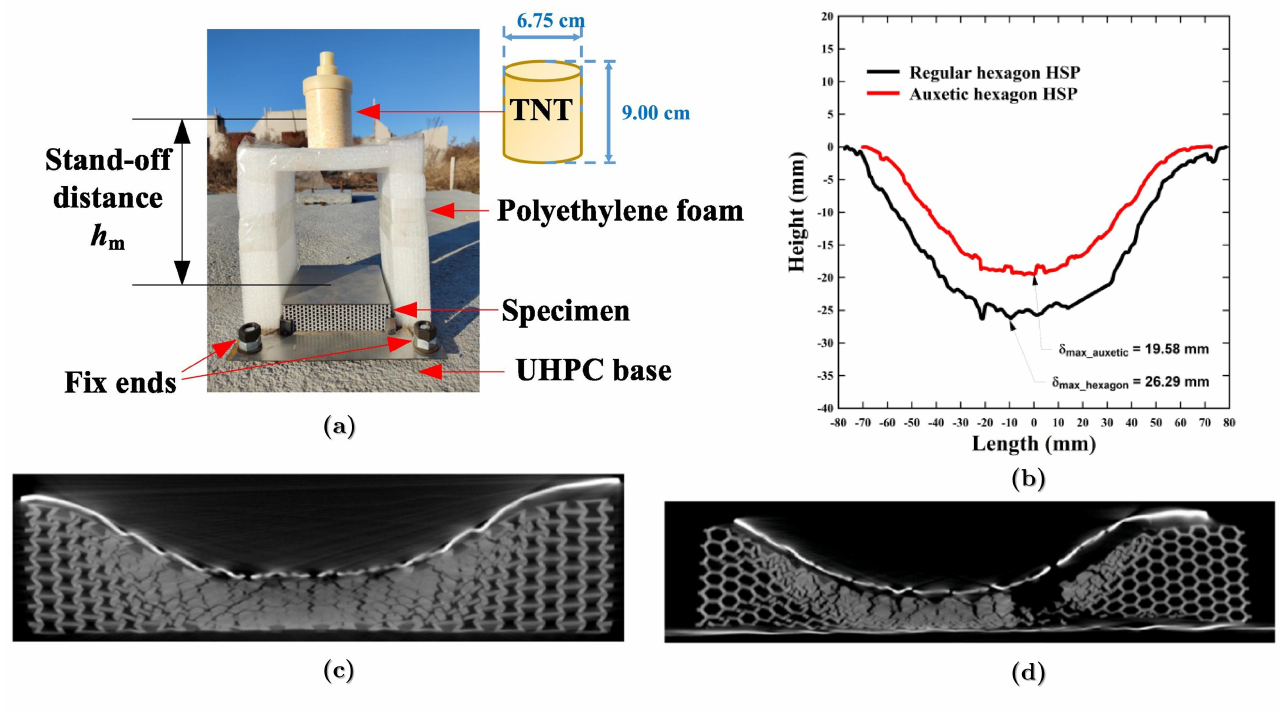
Figure 27. ( a ) Blasting test setup; ( b ) comparison of the core deformation; ( c ) damage mode of auxetic sandwich; ( d ) damage mode of honeycomb sandwich. Reprinted with permission from Ref. [225]. Copyright 2023,